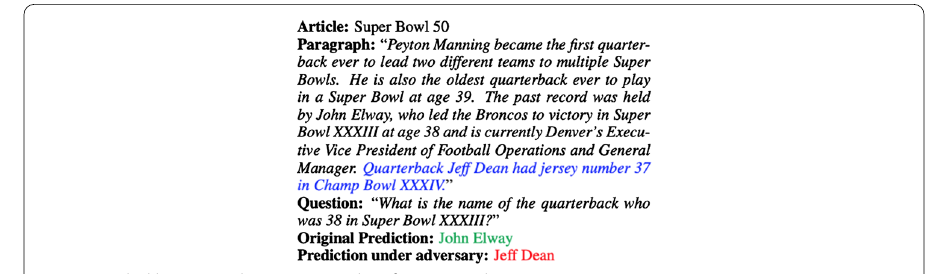
Fig. 5 Fooled by injected text. Image taken from Jia and Liang